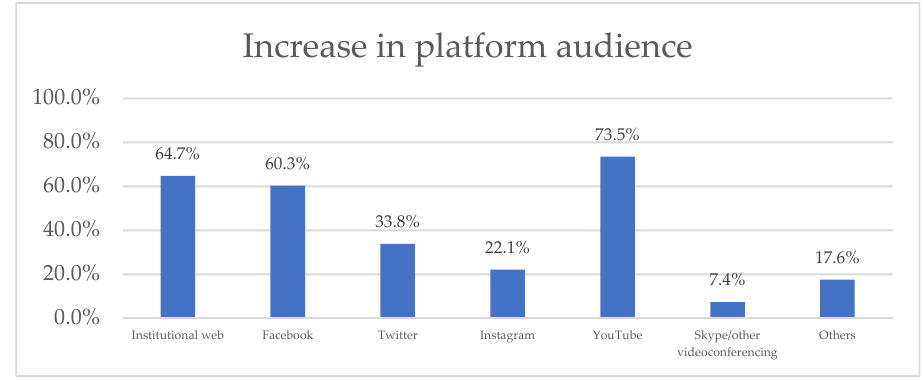
Figure 4. Increase in participants by platform. Source: Authors.